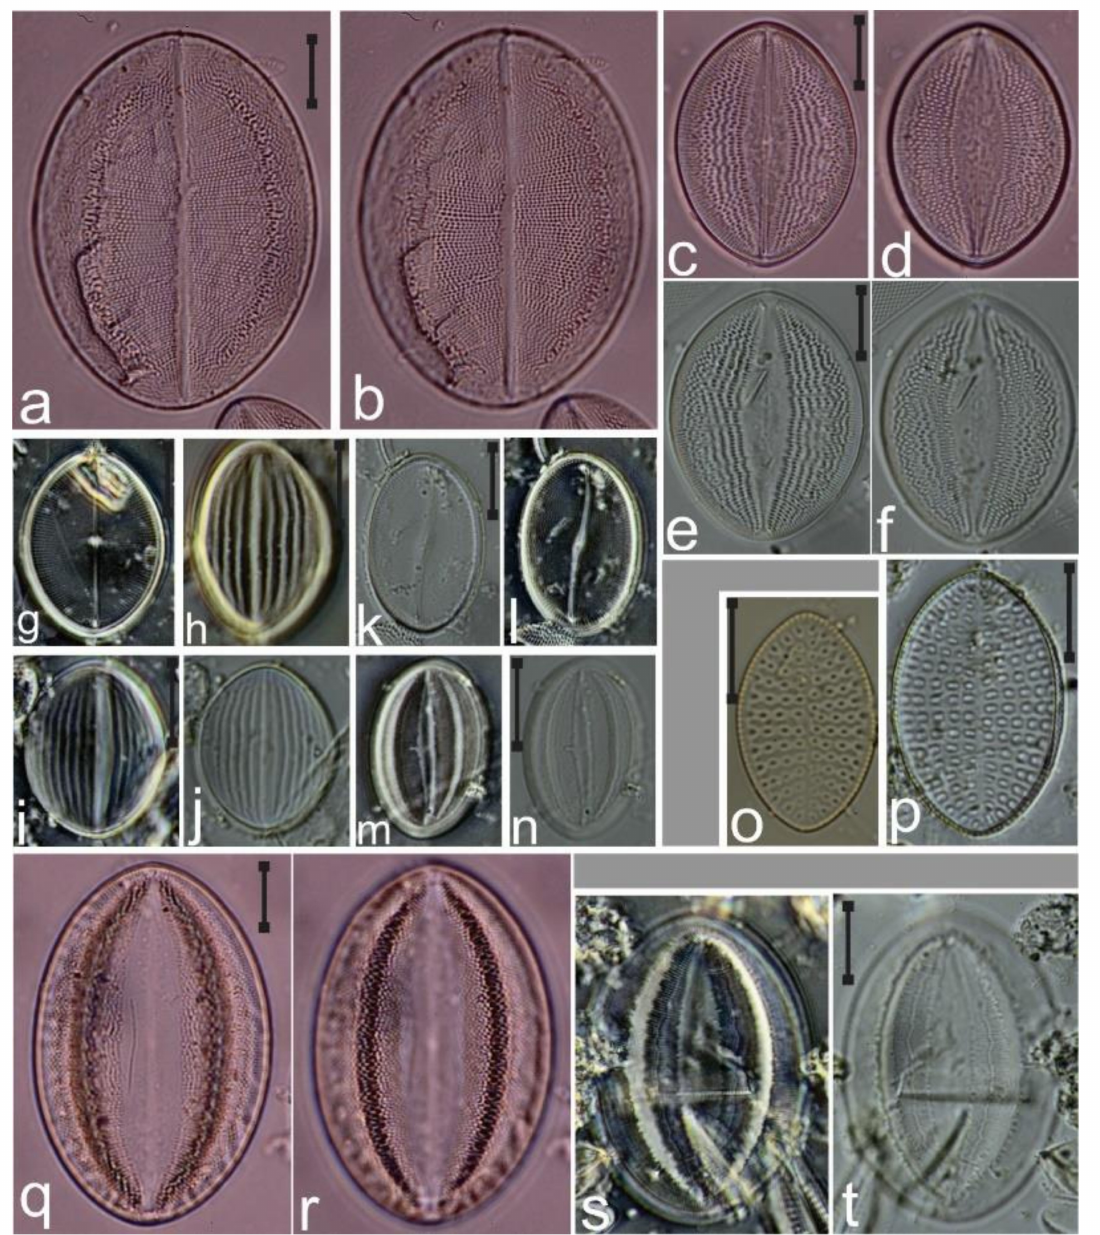
Figure 24. ( a , b ) Cocconeis lineata ; ( c – f ) C. contermina raphe valves at di ff erent focal planes; ( g – j ) C. convexa , image g raphe valve, images h – j sternum valves; ( k – n ) C. krammeri , images k and l raphe, images m and sternum valves; ( o , p ) C. guttata ; ( q – t ) C. pseudomarginata . Scale bar = 10 µ